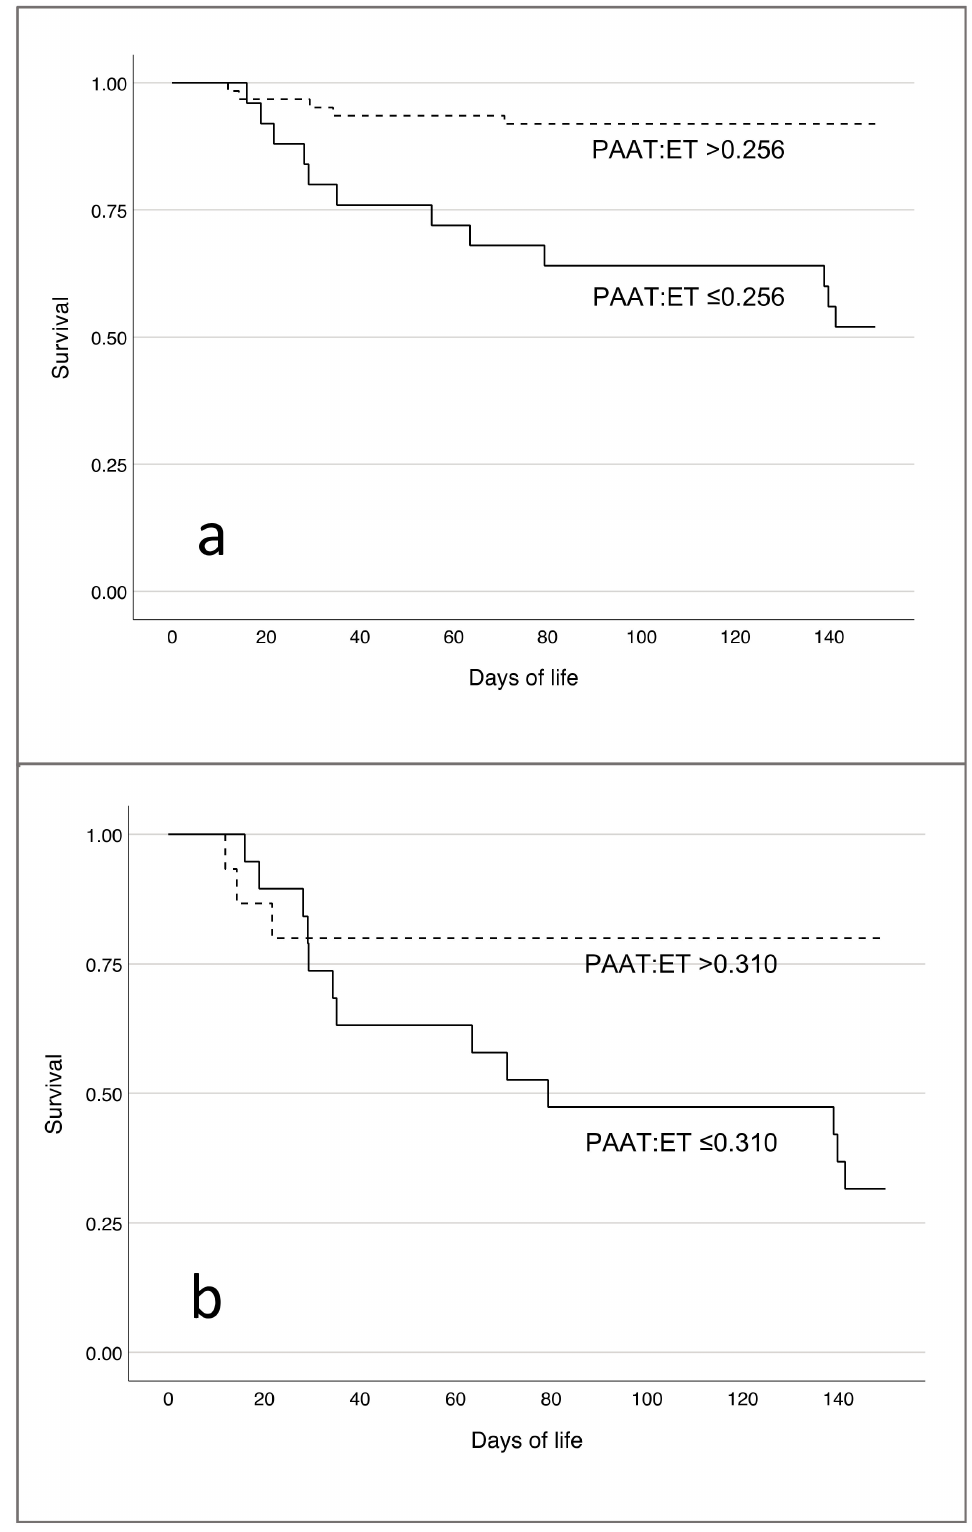
Figure 4. Cumulative survival for patients with a PAAT:ET cutoff of 0.256 at baseline ( a ) and 0.310 on day 5–7 in ECMO patients ( b